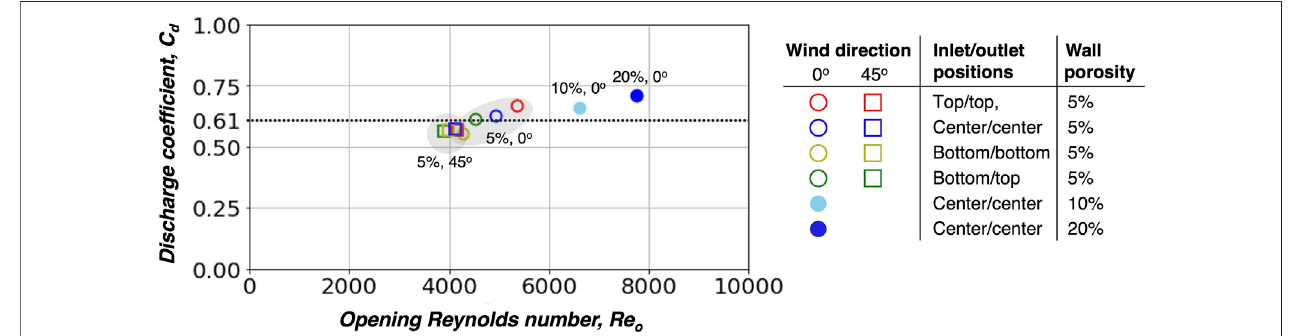
FIGURE 9 | Total discharge coef fi cient vs. opening Reynolds